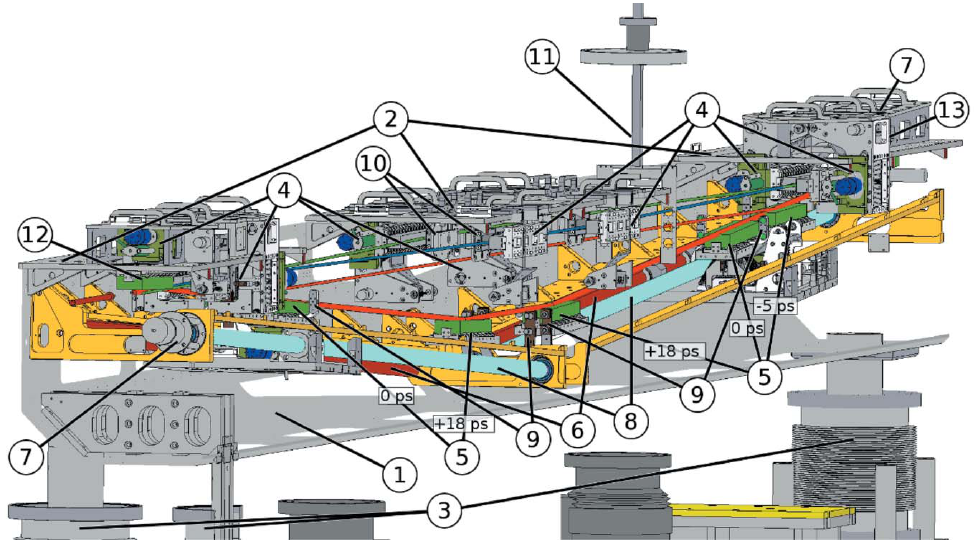
Figure 4 Mechanical structure of the SDU. (1) Optical bench, (2) base metal plates, (3) moving base with vacuum bellows, (4) mirror mountings, (5) DL1 and DL2 at (cid:3) 5 ps, 0 ps and +18 ps positions, (6) guiding rails, (7) UHV-compatible stepper motors of the delay stage, (8) ball screw drives, (9) two beam interferometer, (10) relative pulse intensity measurement device, (11) retractable blocking stages with filters, (12) beam splitter BS, (13) recombination mirror RC.